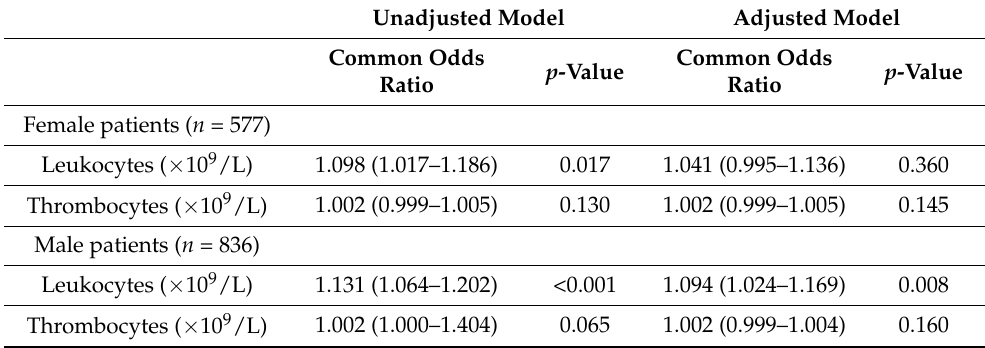
Table 3. Leukocytes and thrombocytes as predictors of the presence of